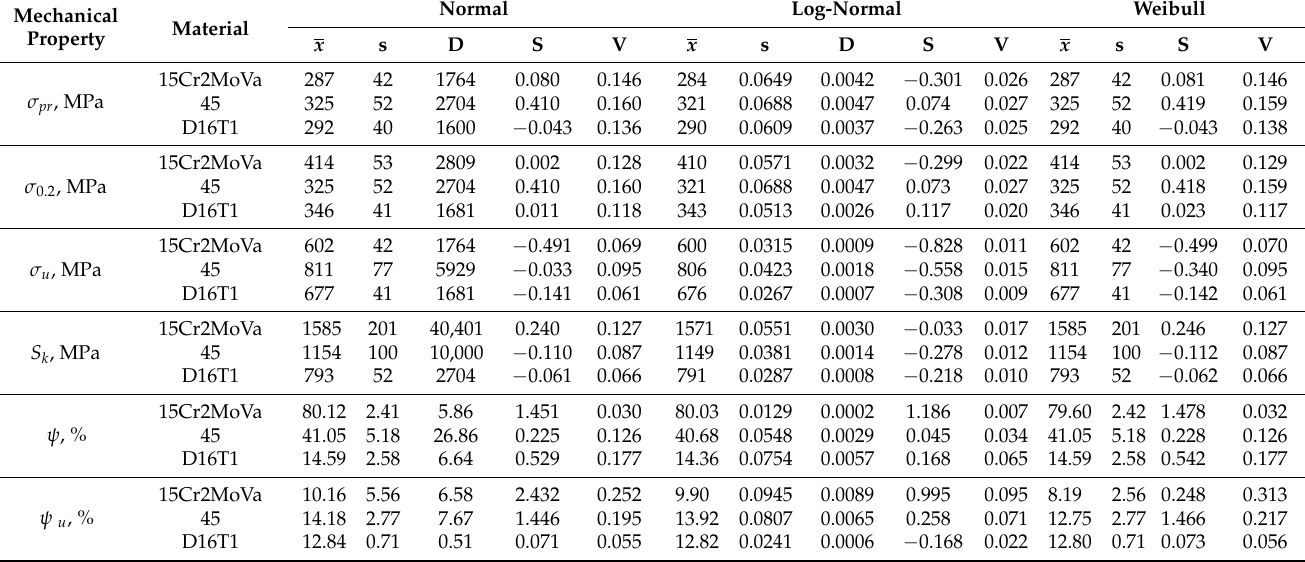
Table 3. Statistical characteristics for normal, log-normal, and Weibull